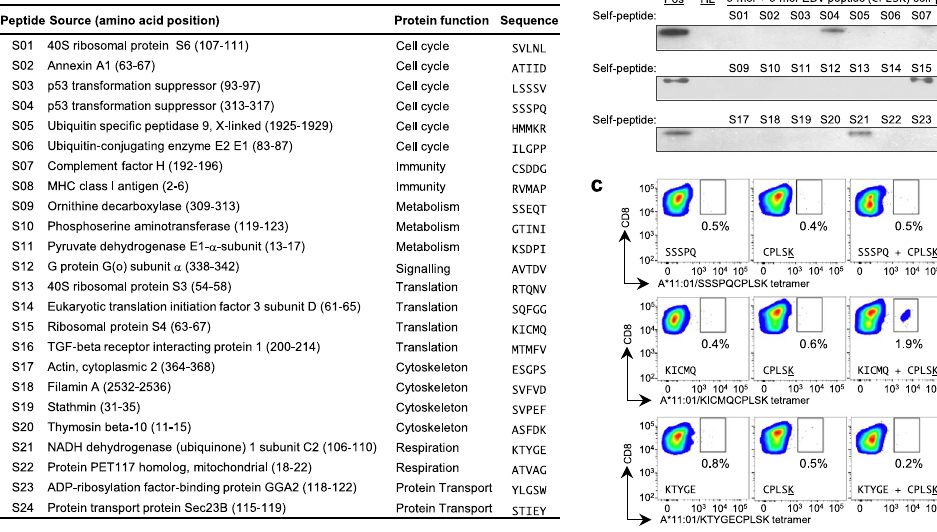
Figure 5. Presence of T cells activated by combination of short peptides from self and non-self antigens. ( a ) List of N-terminal 5mer peptides from endogenous self-protein known to bind HLA-A * 11:01 that were used for refolding screening. ( b ) Native western blot screening results indicate formation of stable pHLA complexes from refolded HLA-A * 11:01 heavy chain, β 2 m and EBV LMP2 C-terminal 5mer peptide (CPLSK) together with three self-peptides (S4:SSSPQ, S15:KICMQ and S21:KTYGE). ( c ) Detection of CD8 + T cells that recognize self and non-self combinatorial epitope in 14-day PBMC culture of a representative HLA-A * 11:01 homozygous individual after stimulation with endogenous self 5mer N-terminal peptides (S4, S15 and S21), CPLSK peptide or the combinatorial self and non-self